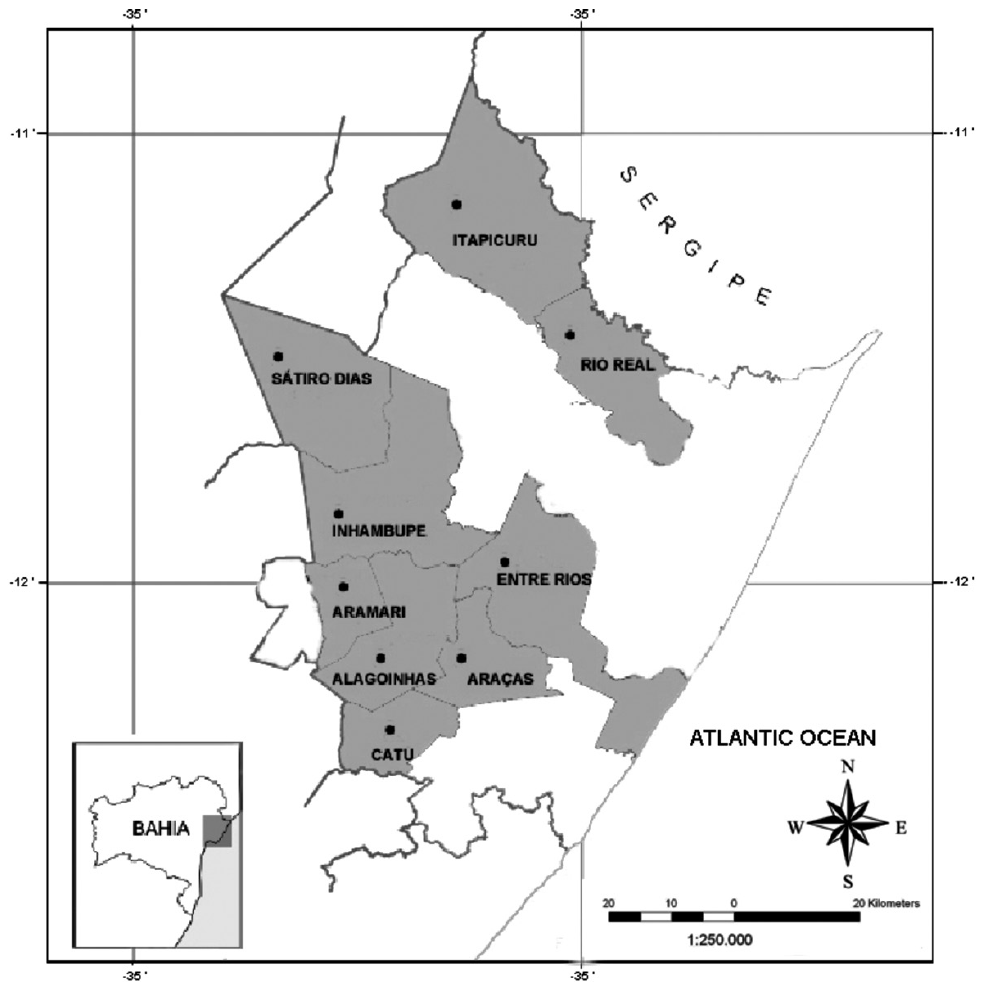
Figure 1 - Territory of the Agreste of Alagoinhas, highlighting the municipalities (in gray) where the propolis samples were collected (Adapted from SEI